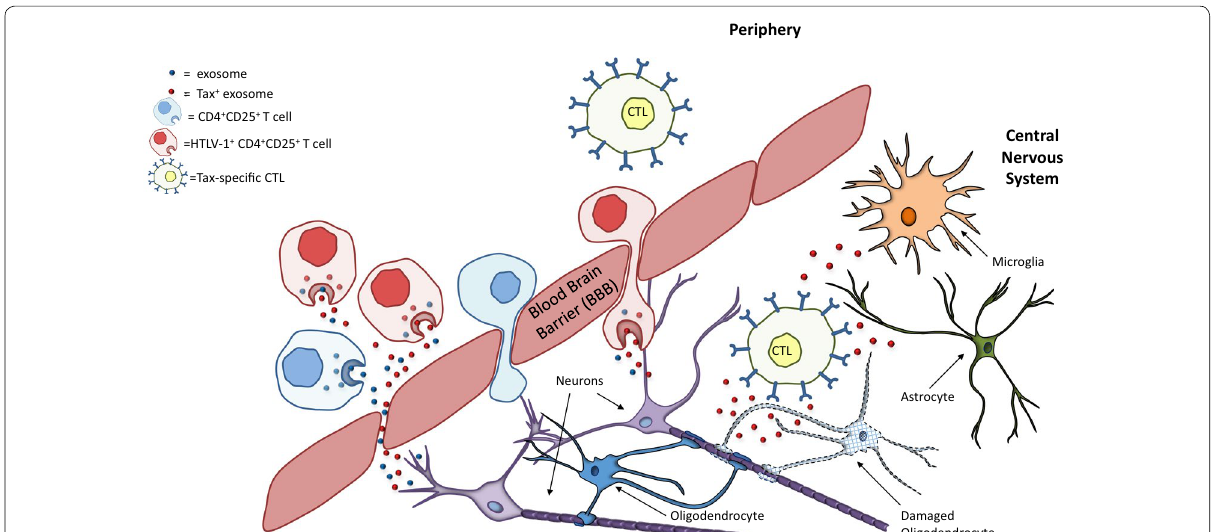
Fig. 7 Hypothesized contribution of exosomes to HAM/TSP immunopathogenesis. HTLV‑1 infected PBMCs, especially HTLV‑1 infected CD4 + CD25 + T cells, produce exosomes containing HTLV‑1 Tax. These cells are present in the periphery and produce Tax + exosomes in the periphery that can potentially cross the blood brain barrier (BBB). However, these infected T cells are also capable of crossing the BBB and producing exosomes in the CNS. Both scenarios may explain the presence of Tax + exosomes in HAM/TSP patient CSF. These Tax + exosomes can then be taken up by CNS resident cells, including microglia, oligodendrocytes, astrocytes, etc. and become targets for lysis by HTLV‑1 Tax‑specific CTLs which cross the BBB. The resulting destruction perpetuates the neuroinflammation observed in